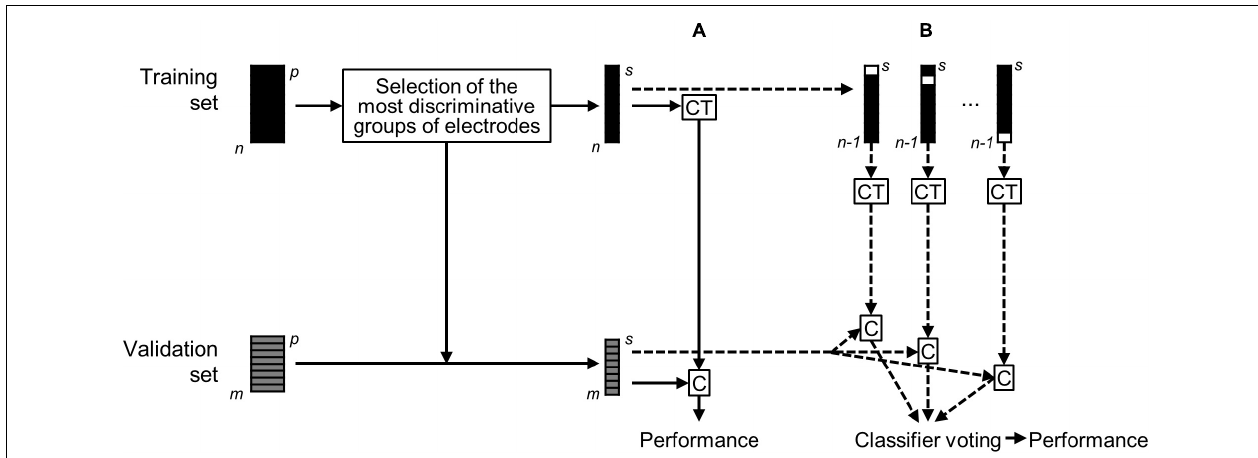
FIGURE 1 | Schematics depicting validation of the statistical model. Only the eight most discriminative groups of electrodes defined from the training set were selected. Then, classifier training (CT) based on the reduced training set of n = 60 patients and classification (C) of the reduced validation set of m = 8 patients was performed in two approaches: (A) a single classifier trained on all n subjects from the training set; (B) voting of n classifiers trained on n –1 subsets of the training set.